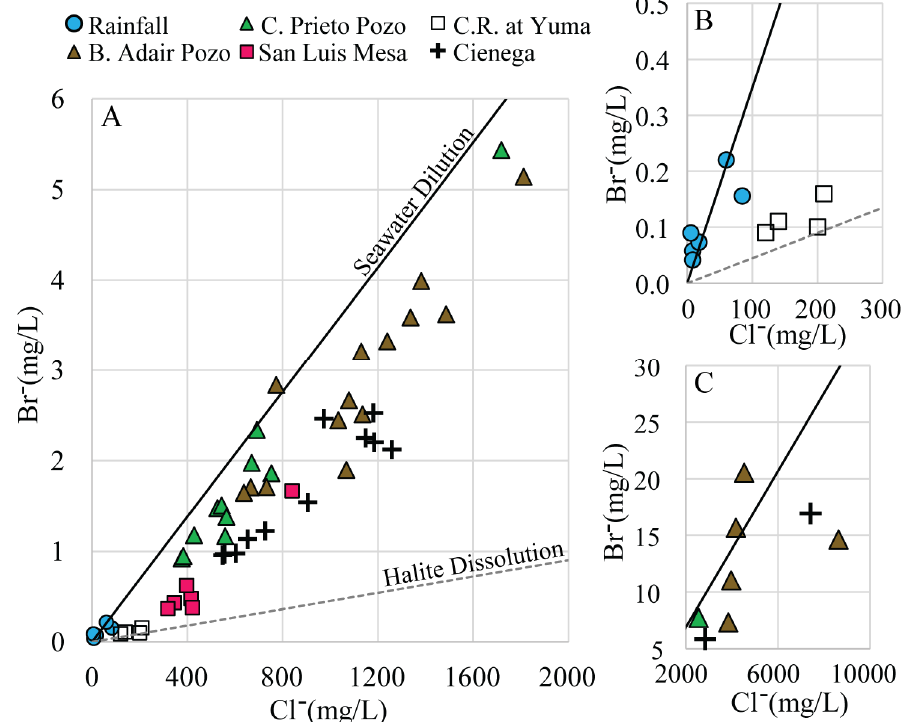
Figure 10. ( A ) Br – vs. Cl – (mg / L) values for water samples in the study area. ( B ) Detailed view of the lower end of graph A. ( C ) Extension of graph A to higher salinity. Colorado River water (C.R.) at Yuma obtained was from USGS Station 09404200 [30].